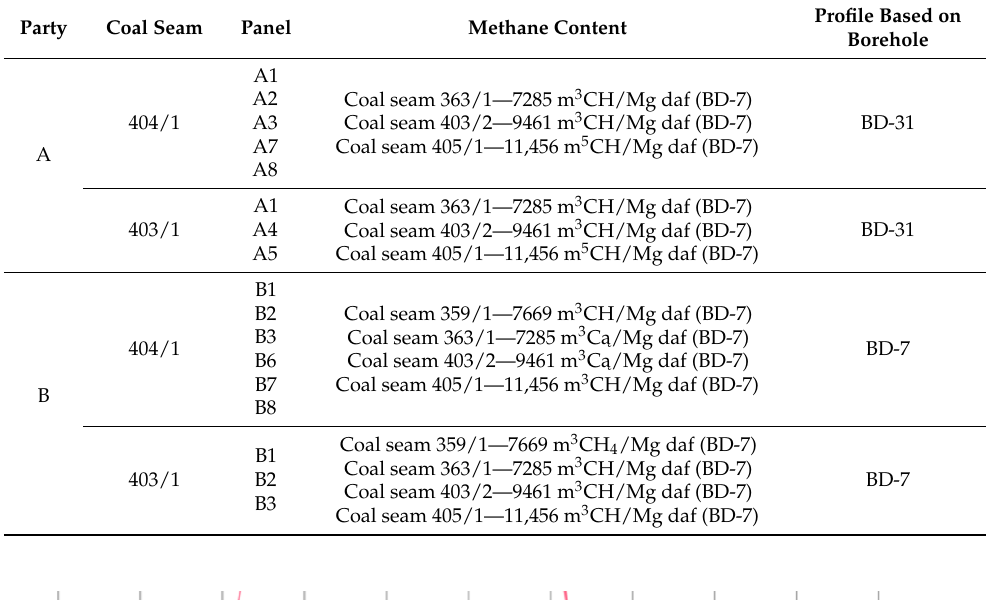
Table 5. Methane volume of parties A and B of coal seams 404/1 and 403/1.